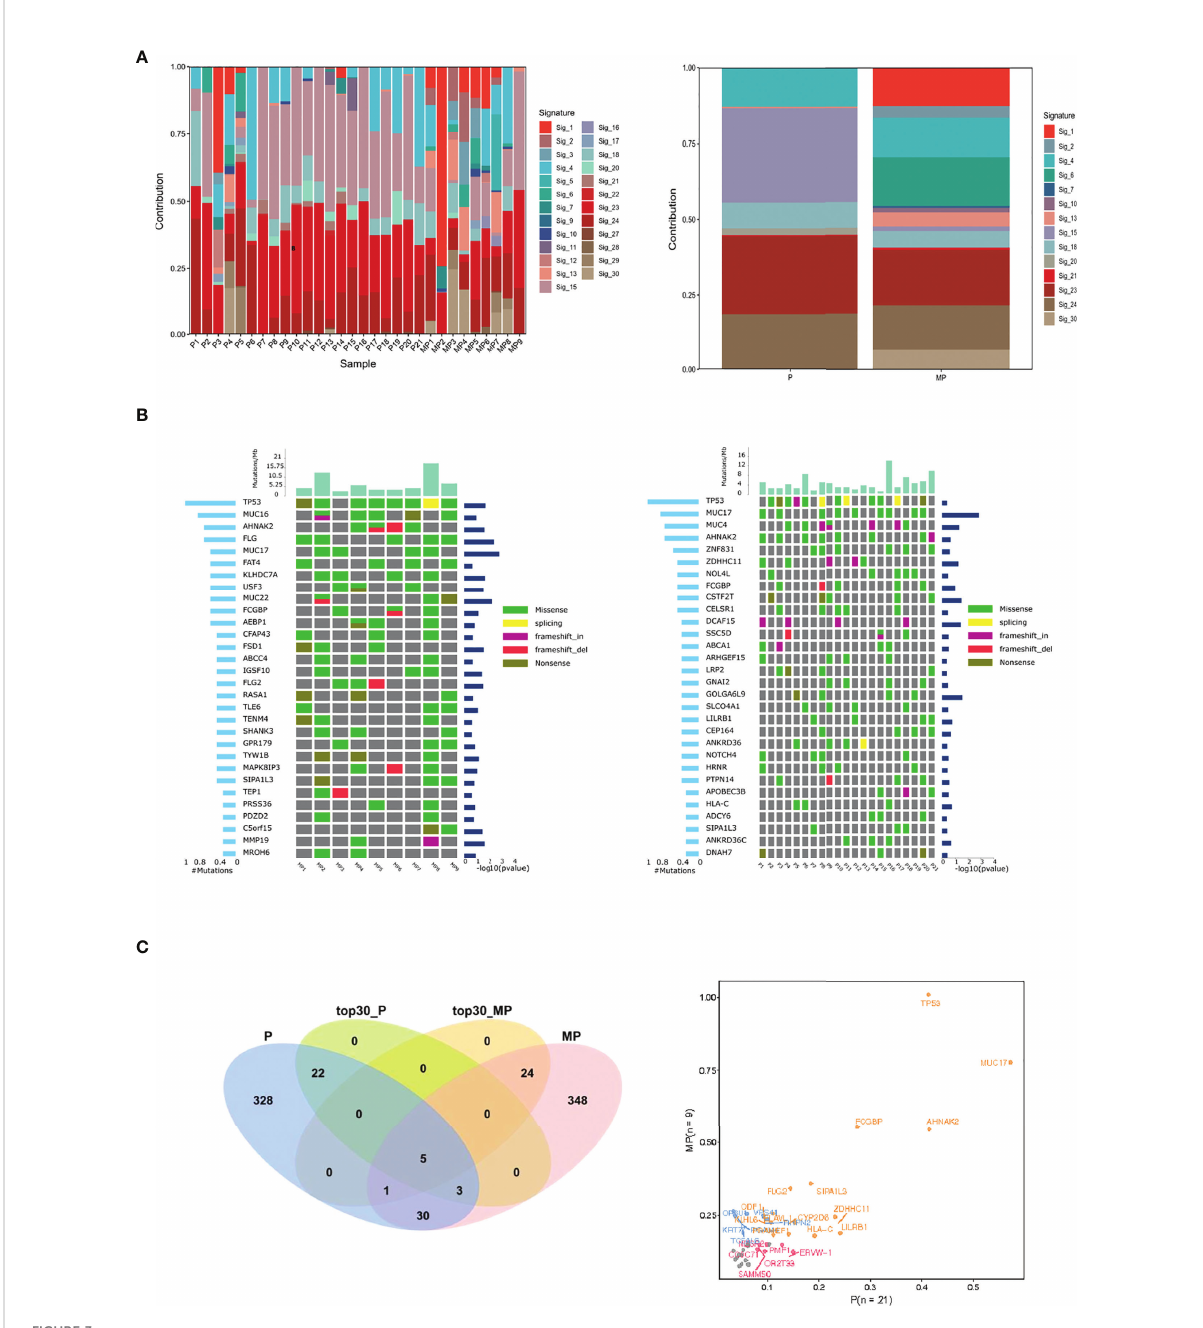
FIGURE 3 Mutational signature, frequent mutated genes of MP-OC and P-OC patients. Decomposition of mutational signatures; all somatic substitutions identi fi ed in this study were included to decipher mutational signatures. The bar plots show the details of 30 patients (left), their relative contribution, and differences between the two groups (right) (A) . The landscape offrequent mutated genes in MP-OC (left) and P-OC (right) groups. The middle panel shows the somatic mutations by patient (column) and by gene (row). The histogram at the top shows the number of mutations accumulated in each individual sample, and mutation types are marked with different colors (B) . Venn diagram showing the differences of signi fi cantly mutated genes. The right fi gure lists the genes with signi fi cant differences between the two groups in different colors (C)